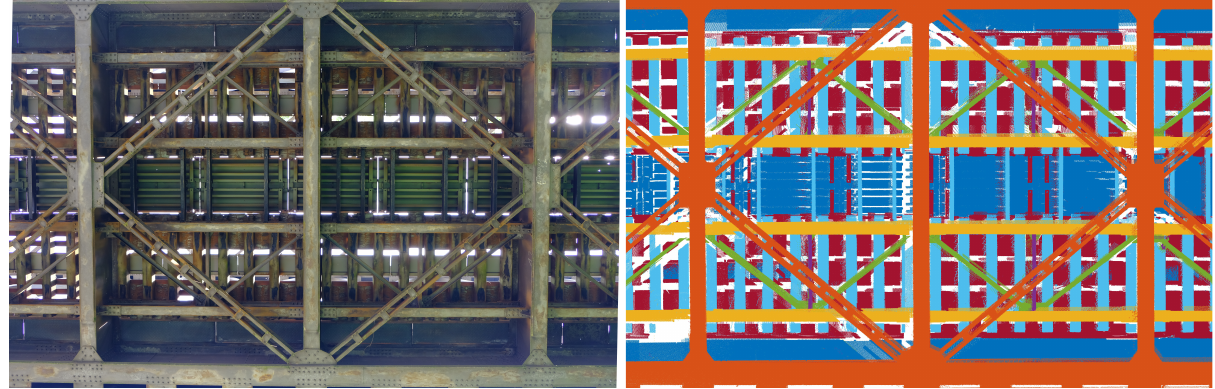
Figure 6. Complex framework of the underside of the bridge: Photograph vs. color-coded (height) laser